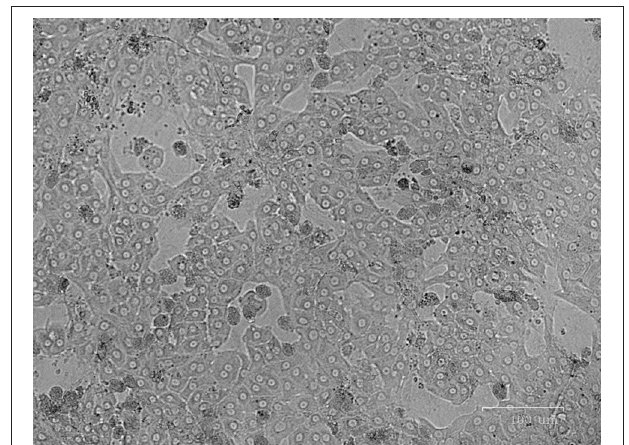
FIGURE 1 | Primary bovine hepatocytes in hormone free control (CTRL) on day 4 of cell culture.